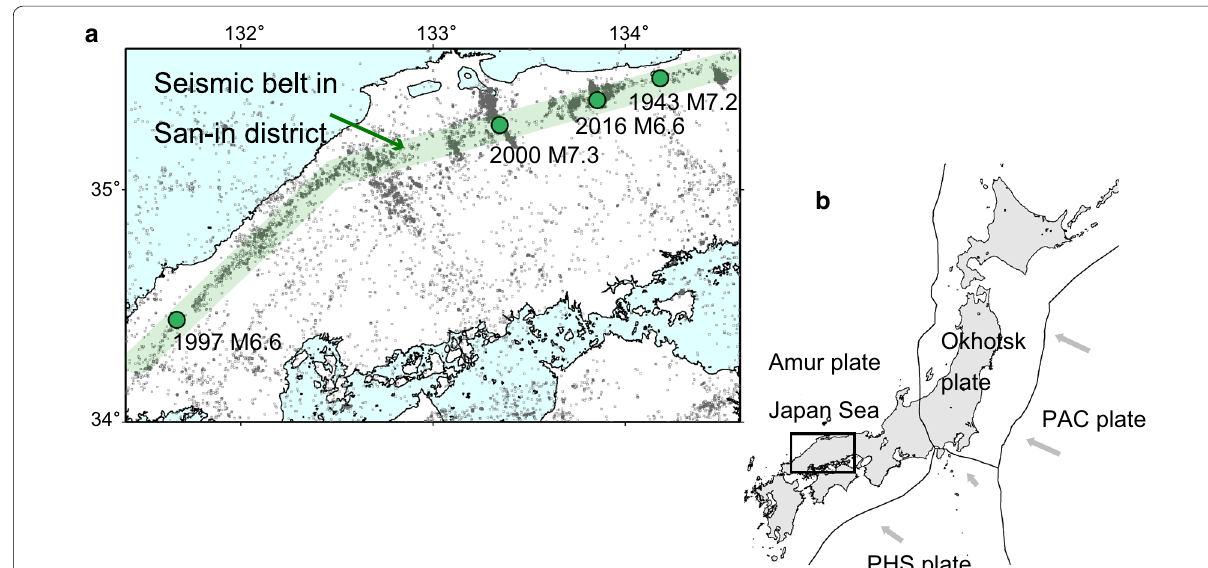
Fig. 1 a The seismic belt in the San-in district. Gray dots denote epicenters of intraplate earthquakes of M J between January 2001 and December 2016. Green circles denote epicenters of large intraplate earthquakes of M J 100 years. b Tectonic setting in and around the Japanese Islands. The rectangle outlines the area shown in a . Gray arrows indicate the plate motion of the oceanic plates relative to the continental